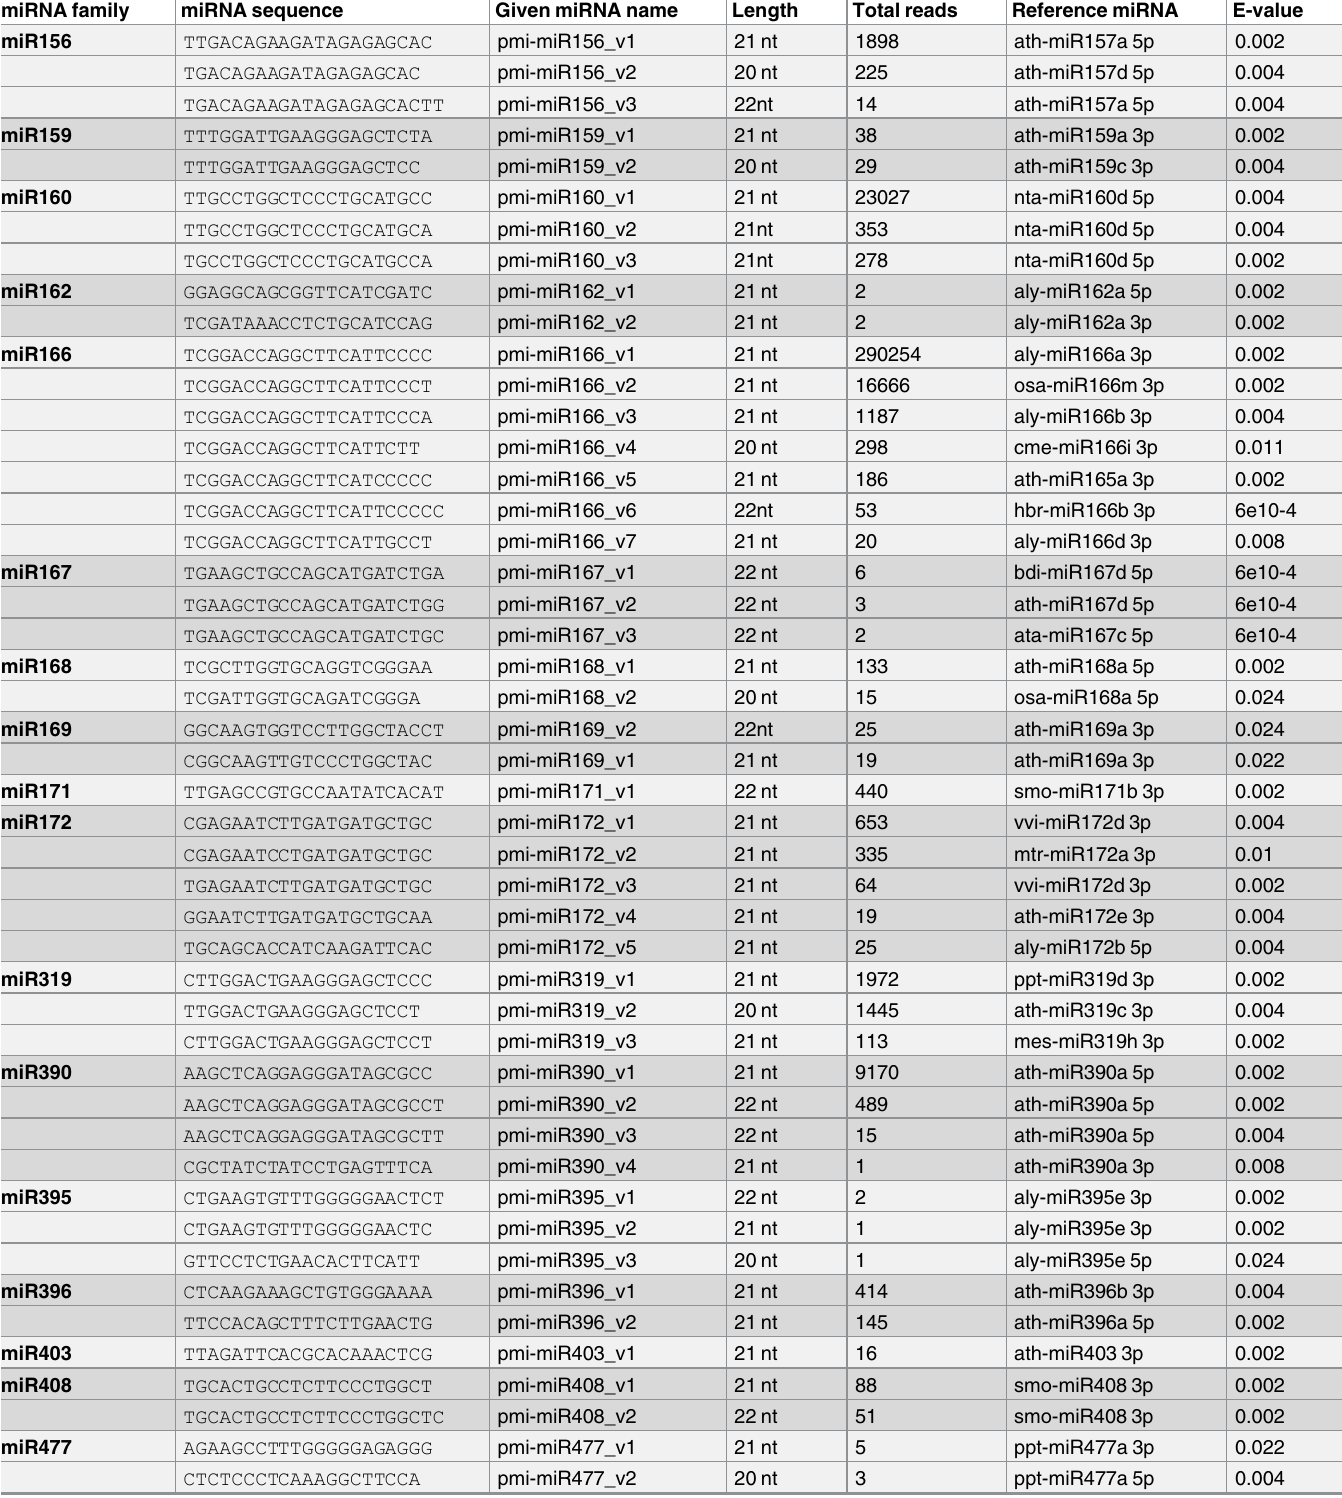
Table 1. Conserved P . minima miRNAs. miRNA